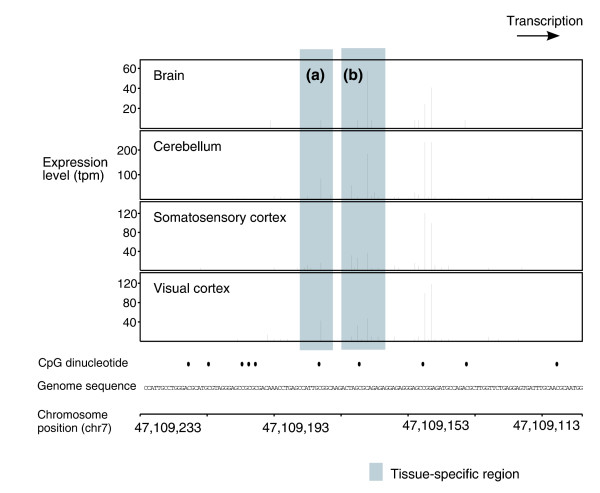
TSS usage and CpG dinucleotides at the 5' end of Snrpn. Expression levels of tag cluster T07R02CED41C, located at the 5' end of Snrpn on the reverse strand of chromosome 7, are shown. Only tissues with tpm (transcripts per million) above 100 and more than ten CAGE tags in the tag cluster are shown, and their expression levels are displayed as histograms. Gray backgrounds indicate regions with different tissue specificity from the remaining part of the tag cluster. Genome sequences are displayed below the graphs, and CpG sites are indicated by dots. CAGE, cap analysis of gene expression; TSS, transcription start site.